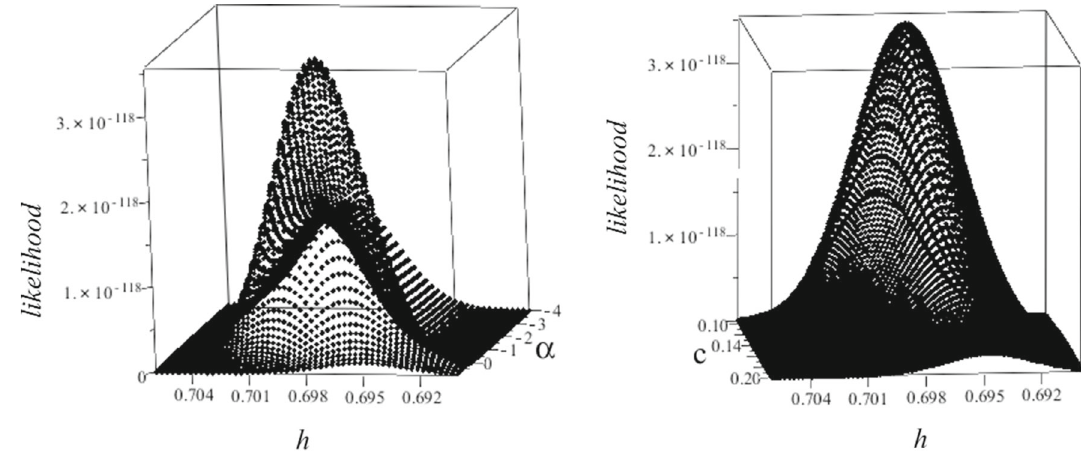
Fig. 1 The graph of the two dimensional likelihood distribution for parameters α and c and h